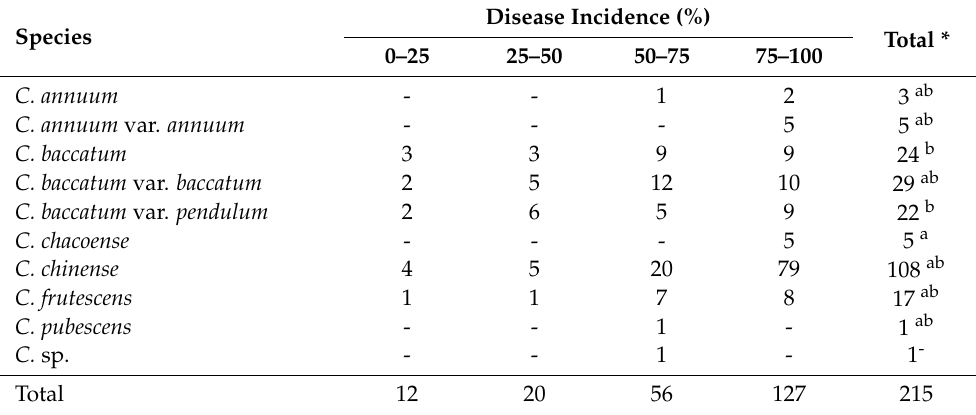
Table 3. Distribution of disease incidence among the selected pepper germplasm resources against C. acutatum by wound